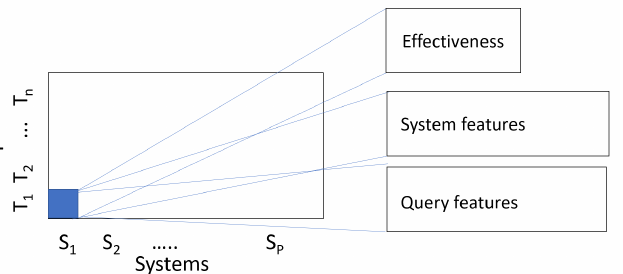
Figure 4. More complex data structures can be used that integrate features on topics, on systems or on